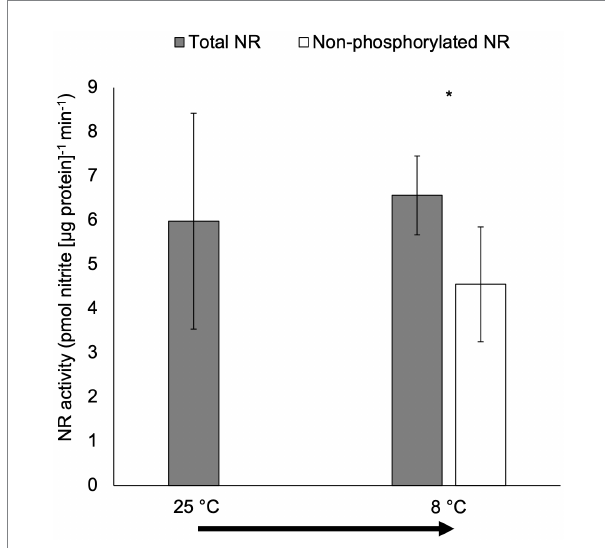
FIGURE 5 Activity (pmol nitrite [ μ g protein] − 1 min − 1 ) of total NR and non- phosphorylated NR in the short-term temperature experiment when the culture was transferred from 25 ° C to 8 ° C (15-min incubation after the transfer; only total NR activity was measured for the culture under 25 ° C). The arrow indicates the short-term temperature change. Samples for NR activity assay were collected at 6 h after lights on. Asterisk (*) reveals the significant difference in NR activity between total and non-phosphorylated NR, indicating the regulation by reversible phosphorylation and the subsequent binding of putative 14-3-3 proteins, at the indicated temperature ( p < 0.05). Error bars are standard deviation of three biological